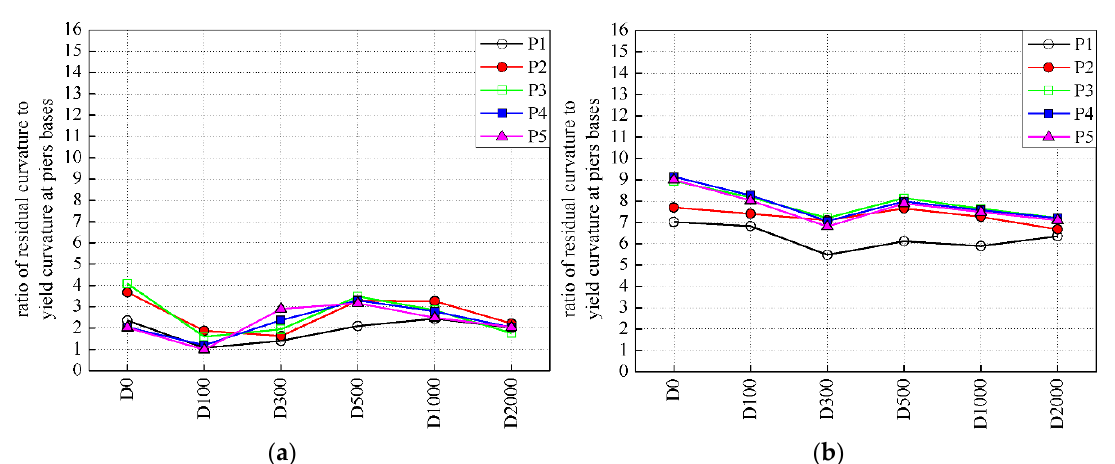
Figure 16. Ratio of residual curvature to yield curvature. ( a ) Stopper = 4 cm. ( b ) Stopper = 8 cm.